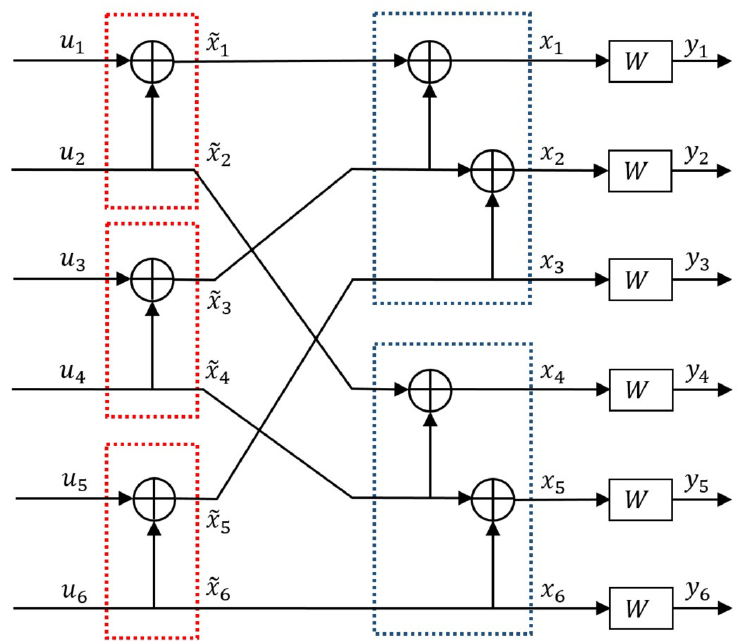
Figure 1. Version A of the 6 × 6 circuit for channel